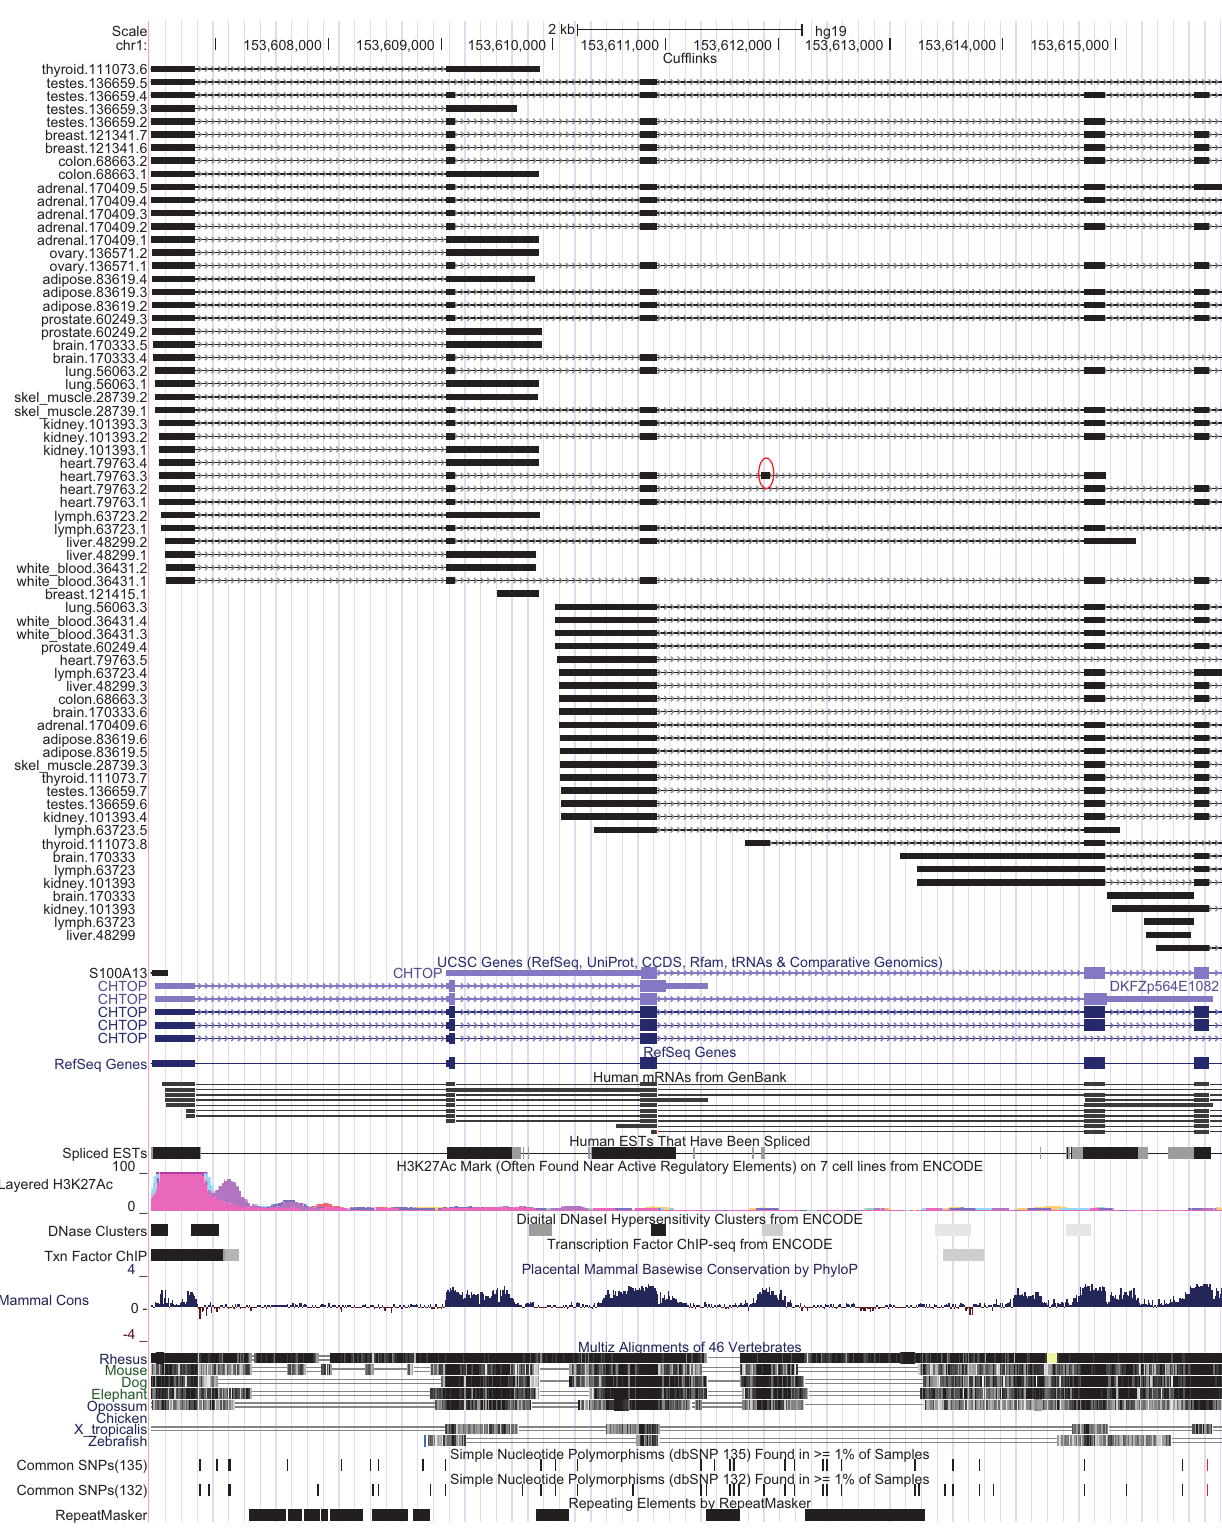
Figure 2. A novel alternatively spliced exon (chr1: 153,611,844–153,611,927) at the CHTOP gene locus, which does not overlap any known annotation. This novel 84-bp exon, marked with a red circle in the figure, is the 4 th exon in one of the transcripts from heart tissue (heart.79763.3), and it appears exclusively in that tissue, although a partial form is present in a skeletal muscle transcript. The two introns flanking the event and the spanning intron are supported by 5, 59 and 702 reads, respectively, in the 16